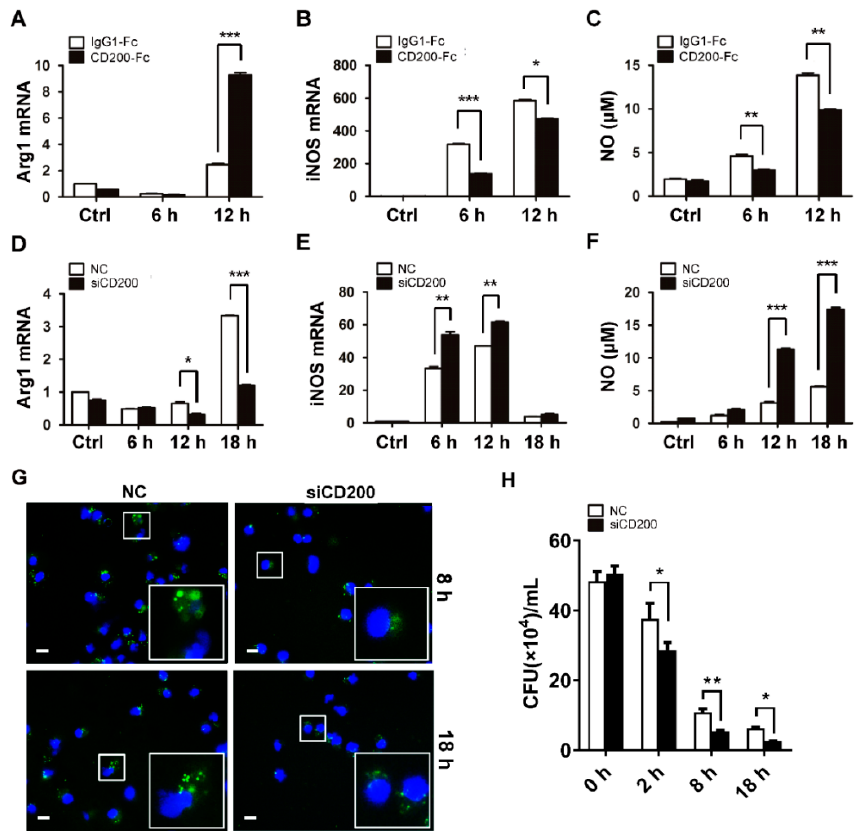
Figure 4. CD200 signaling inhibits NO synthesis and bactericidal activity of S. aureus -infected macrophages. ( A – C ) Mouse BMDMs were pre-treated with CD200-Fc (2 µ g/mL) or IgG1-Fc (2 µ g/mL) for 1 h, and then stimulated with S. aureus (MOI = 1) for indicated time periods (0–12 h). Relative mRNA levels of Arg1 ( A ) or iNOS ( B ) were detected by qPCR. NO release was determined using Griess reagent system ( C ). ( D – F ) Mouse PEMs were transfected with siCD200 or NC siRNA for 48 h, and then stimulated with S. aureus (MOI = 1) for indicated time periods (0–18 h). Arg1 ( D ) and iNOS ( E ) mRNA levels and NO release ( F ) were determined. ( G ) PEMs transfected with siCD200 or NC siRNA were challenged with CFSE-labeled S. aureus (MOI = 10) for indicated time periods (0–18 h). Cells were collected, fixed, and stained with DAPI. Intracellular bacterial were observed using a fluorescence microscope. A partially enlarged view was shown in the lower left corner. Scale bars: 10 µ m. Shown are representative images from three independent experiments. ( H ) Mouse PEMs were transfected with siCD200 or NC siRNA for 48 h, and then challenged with S. aureus (MOI = 10) for indicated time periods (0–18 h). Cells were lysed and the intracellular bacterial burden was determined by CFU counting. Results are expressed as the mean ± SD of three independent experiments; * p < 0.05, ** p < 0.01, *** p < 0.005.